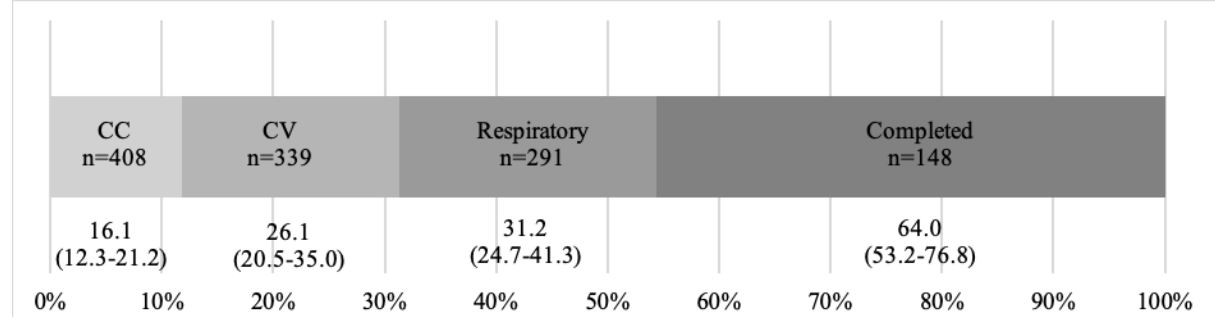
Figure 3. Median durations with IQRs (in minutes) for completed modules and complete interview, excluding pauses >2 minutes. CC: chief